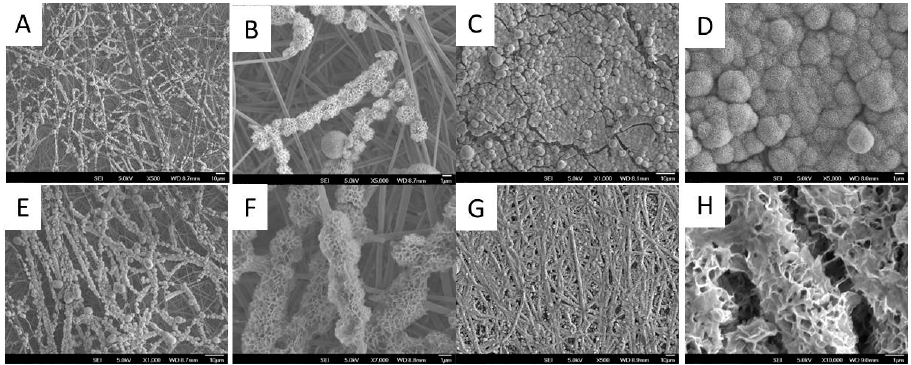
Figure 7. Apatite coating formation on two types of PLLA nanofibers with different treatment: ( A ) Apatite growth survey on PLLA NF at 24 h; ( B ) Apatite growth zoom-in on PLLA NF at 24 h; ( C ) Apatite growth survey on PLLA NF at 48 h; ( D ) Apatite growth zoom-in on PLLA NF at 48 h; ( E ) Apatite growth survey on ECM/PLLA NF at 24 h; ( F ) Apatite growth zoom-in on ECM/PLLA NF at 24 h; ( G ) Apatite growth survey on ECM/PLLA NF at 48 h; ( H ) Apatite growth zoom-in on ECM/PLLA NF at 48 h, after soaking in mSBF for different time periods.